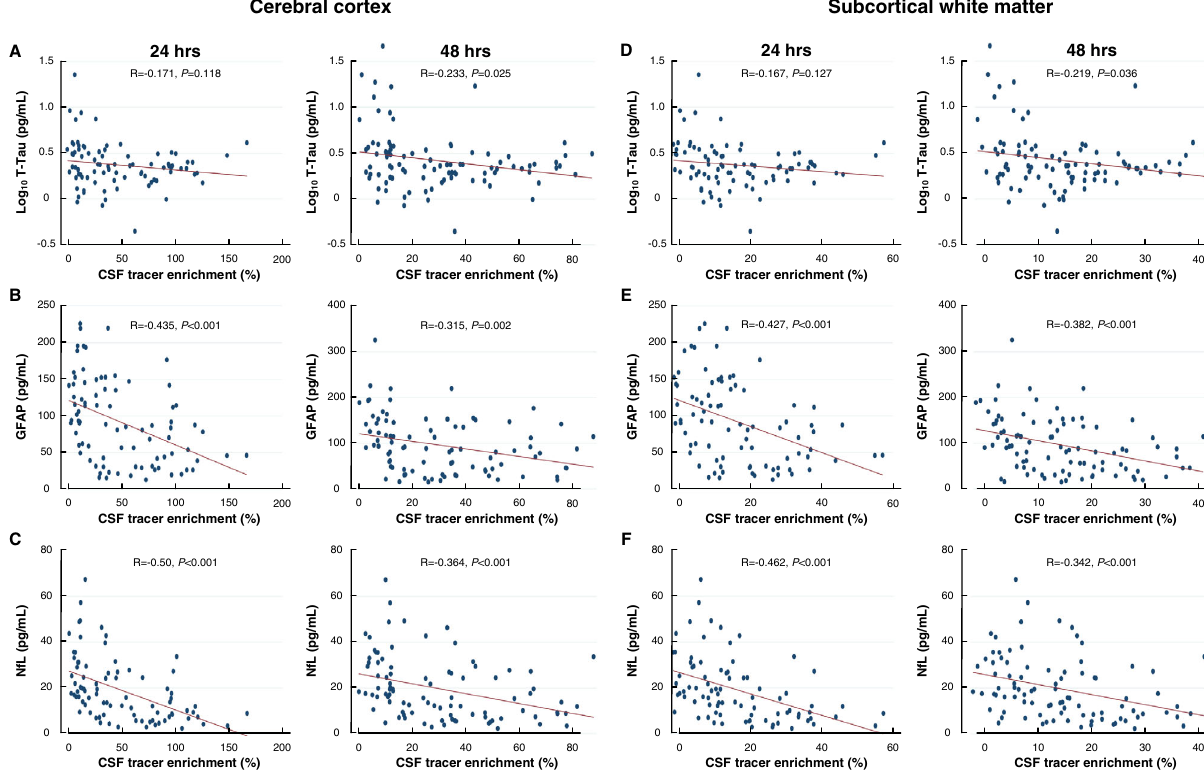
Fig. 2 | Association between plasma concentrations of neurodegeneration biomarkers and enrichment of CSF tracer within the cerebral cortex and subcortical white matter of the entire cohort ( n =106). Plots of associations between tracer enrichment in the cerebral cortex at 24h and average plasma concentrations of A T-tau (log 10 T-tau), B GFAP, and C NfL. Plots for associations